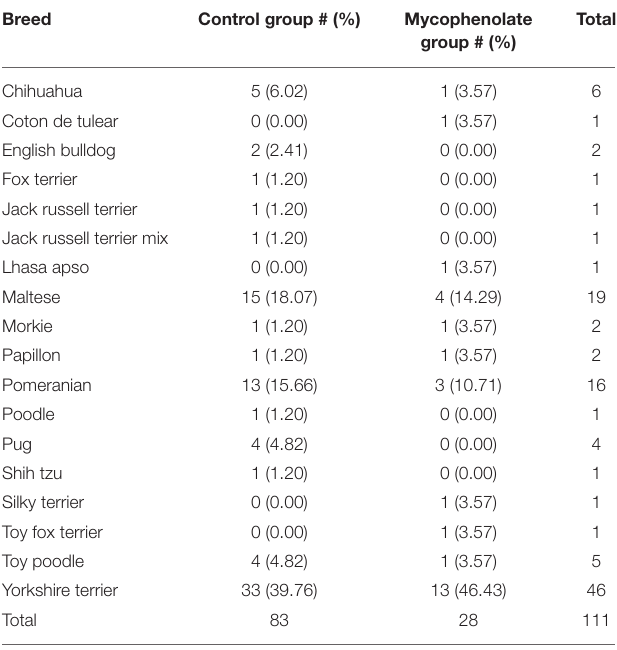
TABLE 1 | Breed distribution of treatment groups. Breed Control group # (%)